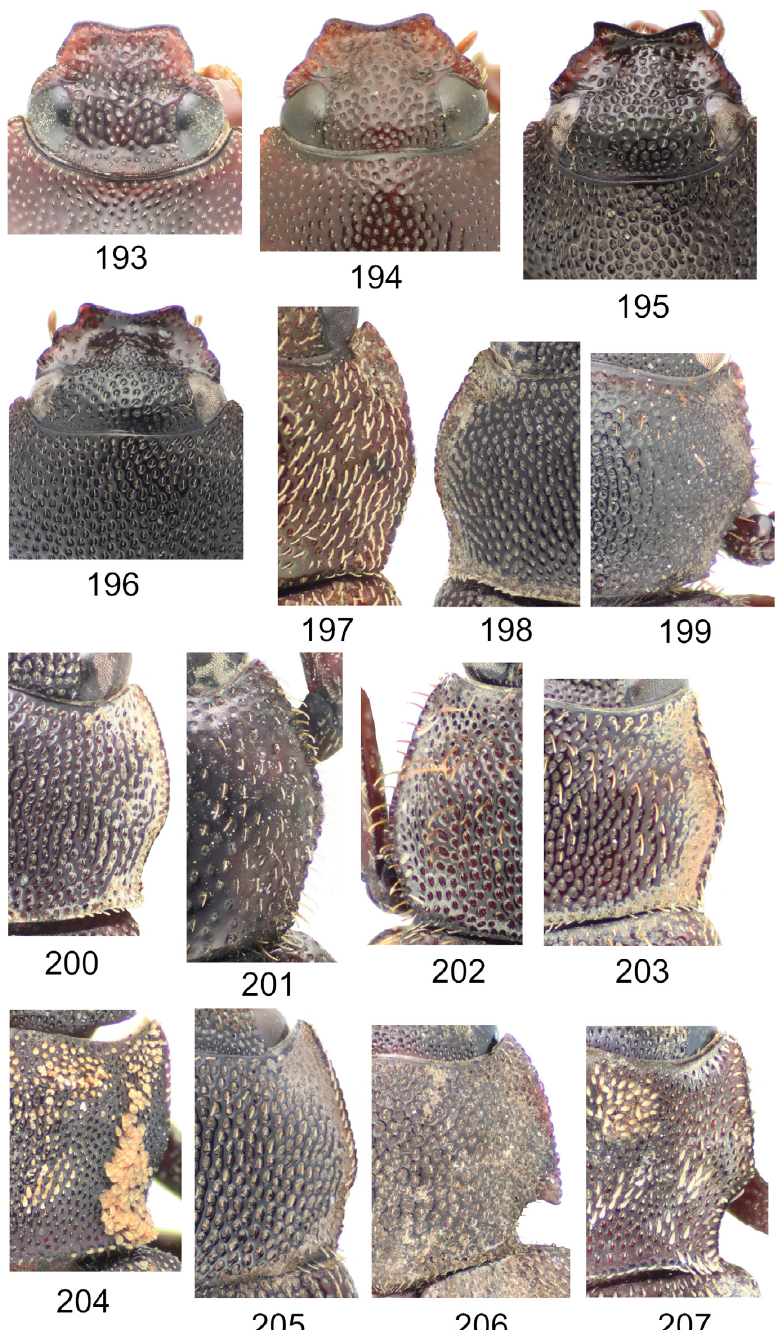
Figs 193–207. Papuan and Wallacean Maechidius Macleay, 1819, head (193–196) and pronotum (197– 207), dorsal view. 193 . M. woodlarkianus Heller, 1914, lectotype, ♀ (SNSD). 194 . Same, ♂